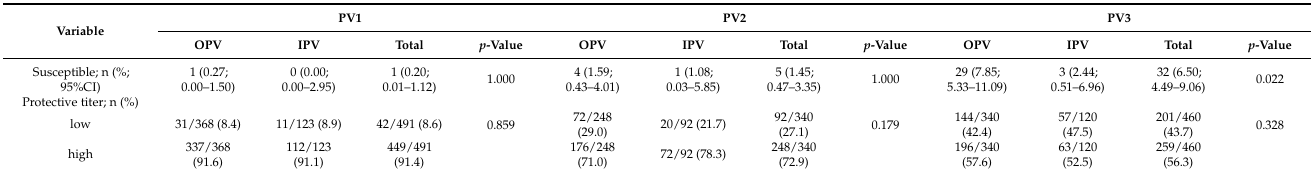
Table 1. Proportion of study participants without poliovirus (PV) neutralizing antibodies and the distribution of the titer (low–high) between groups with respect to vaccination and PV